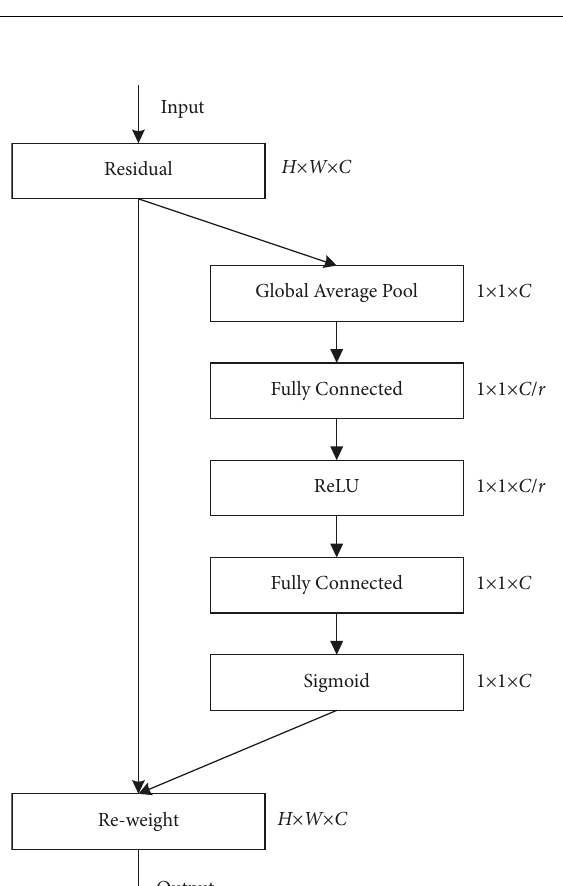
Figure 8: A Squeeze-and-Excitation